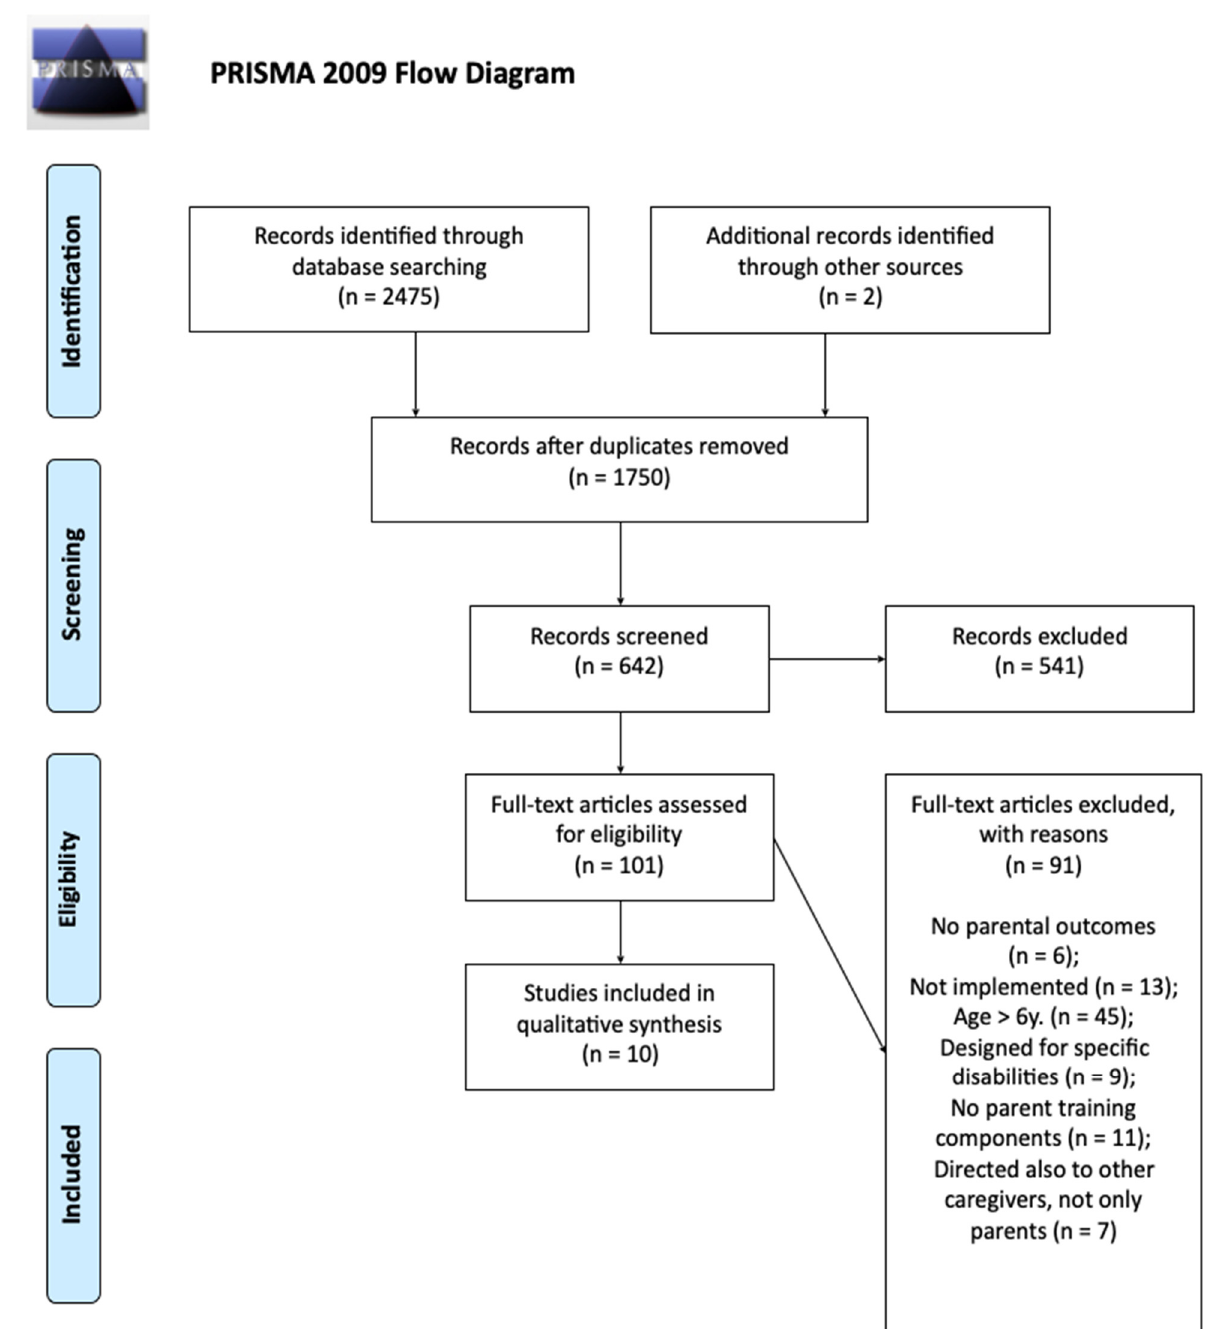
Figure 1. Flowchart for the systematic review